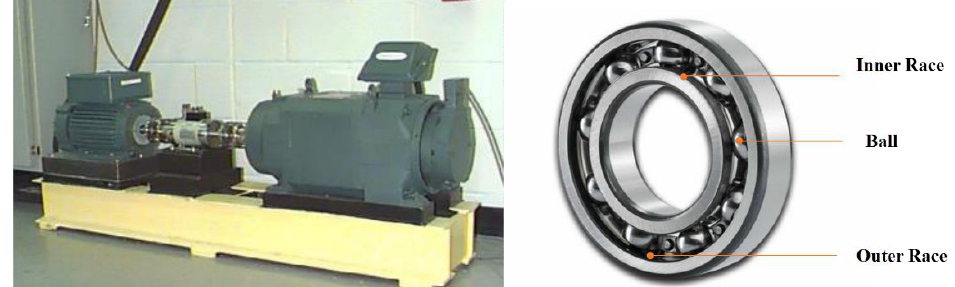
Figure 6. Experimental platform of rolling bearing faults.